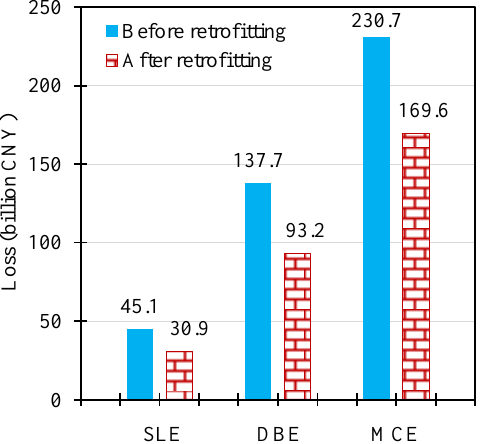
Figure 8. Average total seismic losses of buildings under earthquakes.